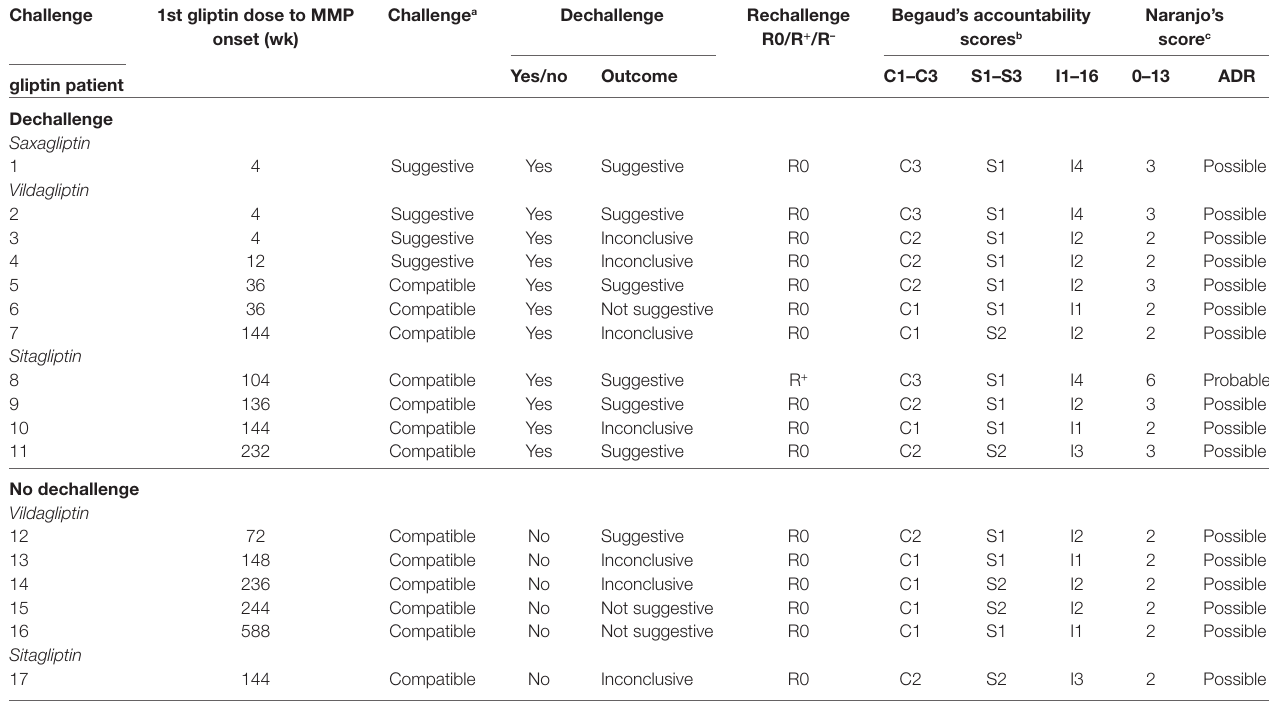
Table 5 | Gliptin accountability scores for suggestive-or-compatible MMP-induction patients.